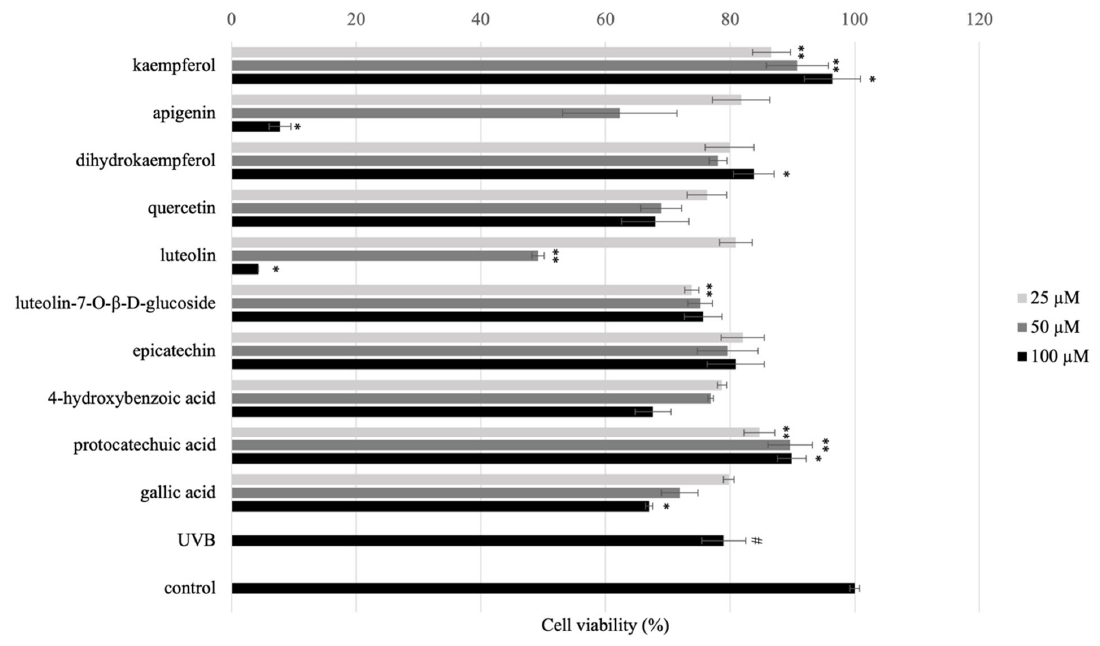
Figure 5. Phototoxicity of the pre ‐ treatment of isolated and/or standard compounds in HaCaT cells (1 × 10 5 cells/mL) with concentrations 25, 50, and 100 μ M. After 24 h, UVB (30 mJ/cm 2 ) was irradiated, and the cells were cultured in serum ‐ free medium for 24 h. The cell viability was performed by MTT assay. The data are expressed as mean ± SD of at least three independent experiments in each group; # p ≤ 0.01, compared with the non-treated control; * p < 0.01; ** p < 0.05 compared with the UV control group. Flavonoids have a chemical structure that consist of a benzene ring (A) condensed with a six ‐ member ring (C) that has a phenyl ring (B) as substituent in the 2 ‐ position (Fig ‐ ure 6A). Flavonoids are divided into six group based on the substitution pattern of ring